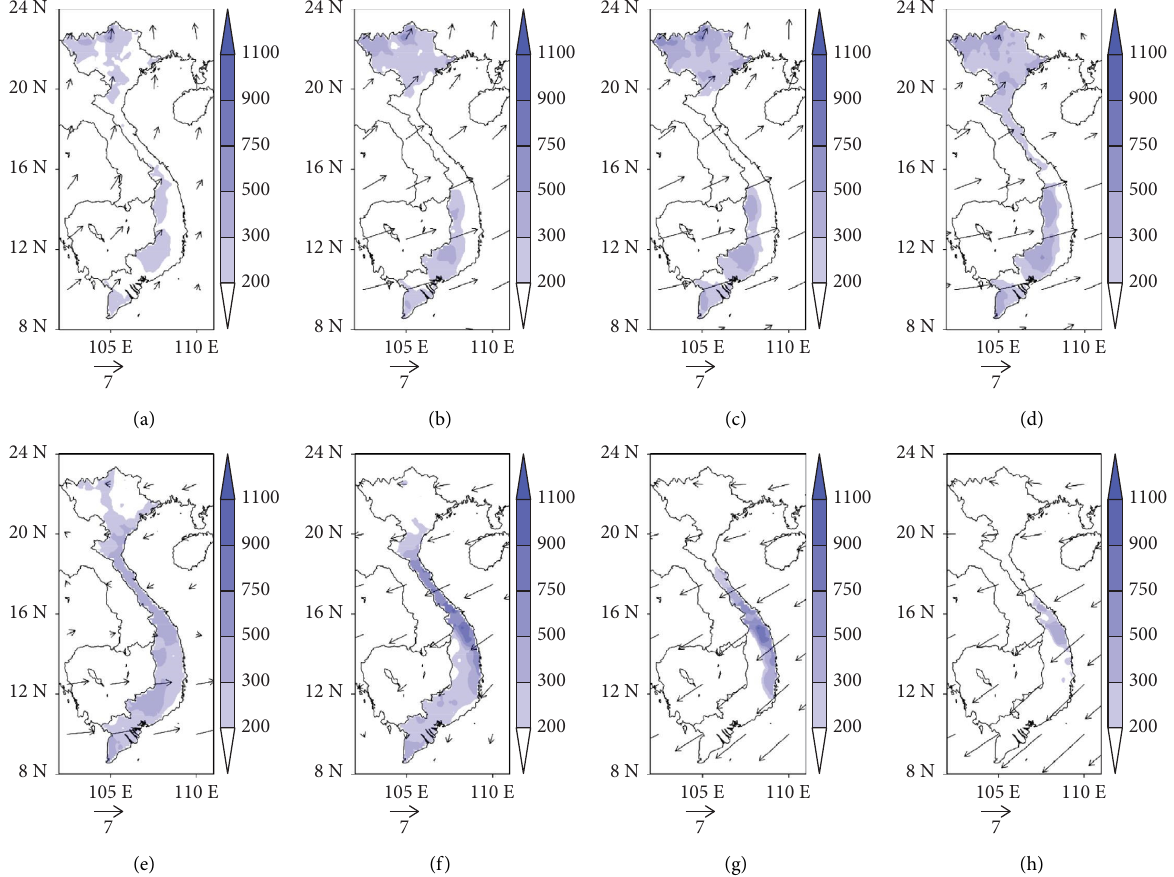
Figure 2: Climatological monthly mean of the VnGP rainfall ( shaded , mm month − 1 ) and 925hPa wind ( vector , ms − 1 ) in the period of